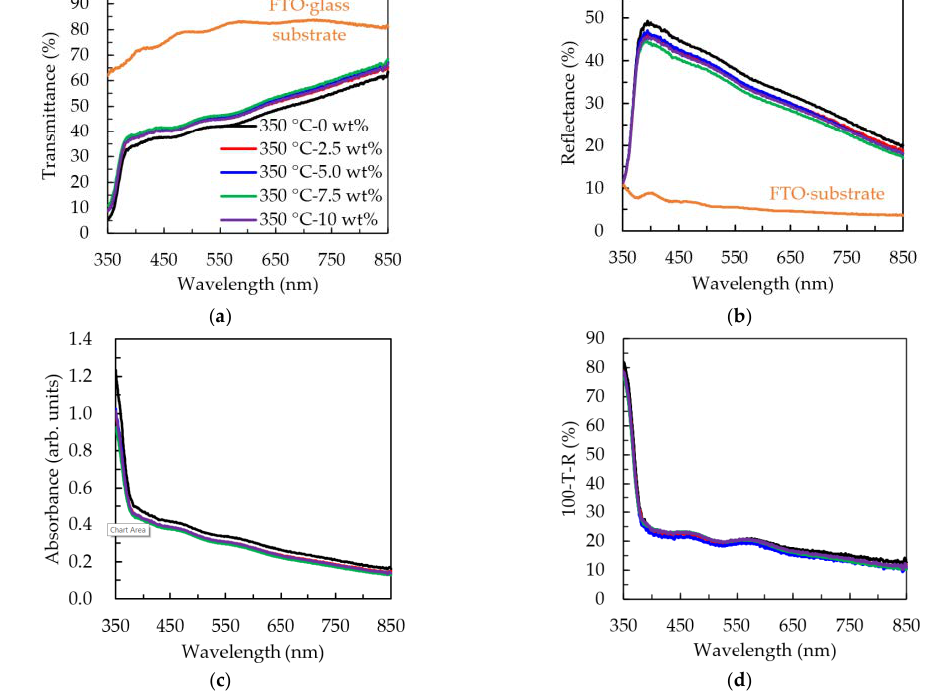
Figure 5. The ( a ) transmittance, ( b ) reflectance, ( c ) absorbance, and ( d ) haze spectra for the 350 °C- annealed TiO 2 film prepared by injecting different DMF doses from 0 to 10 wt%.